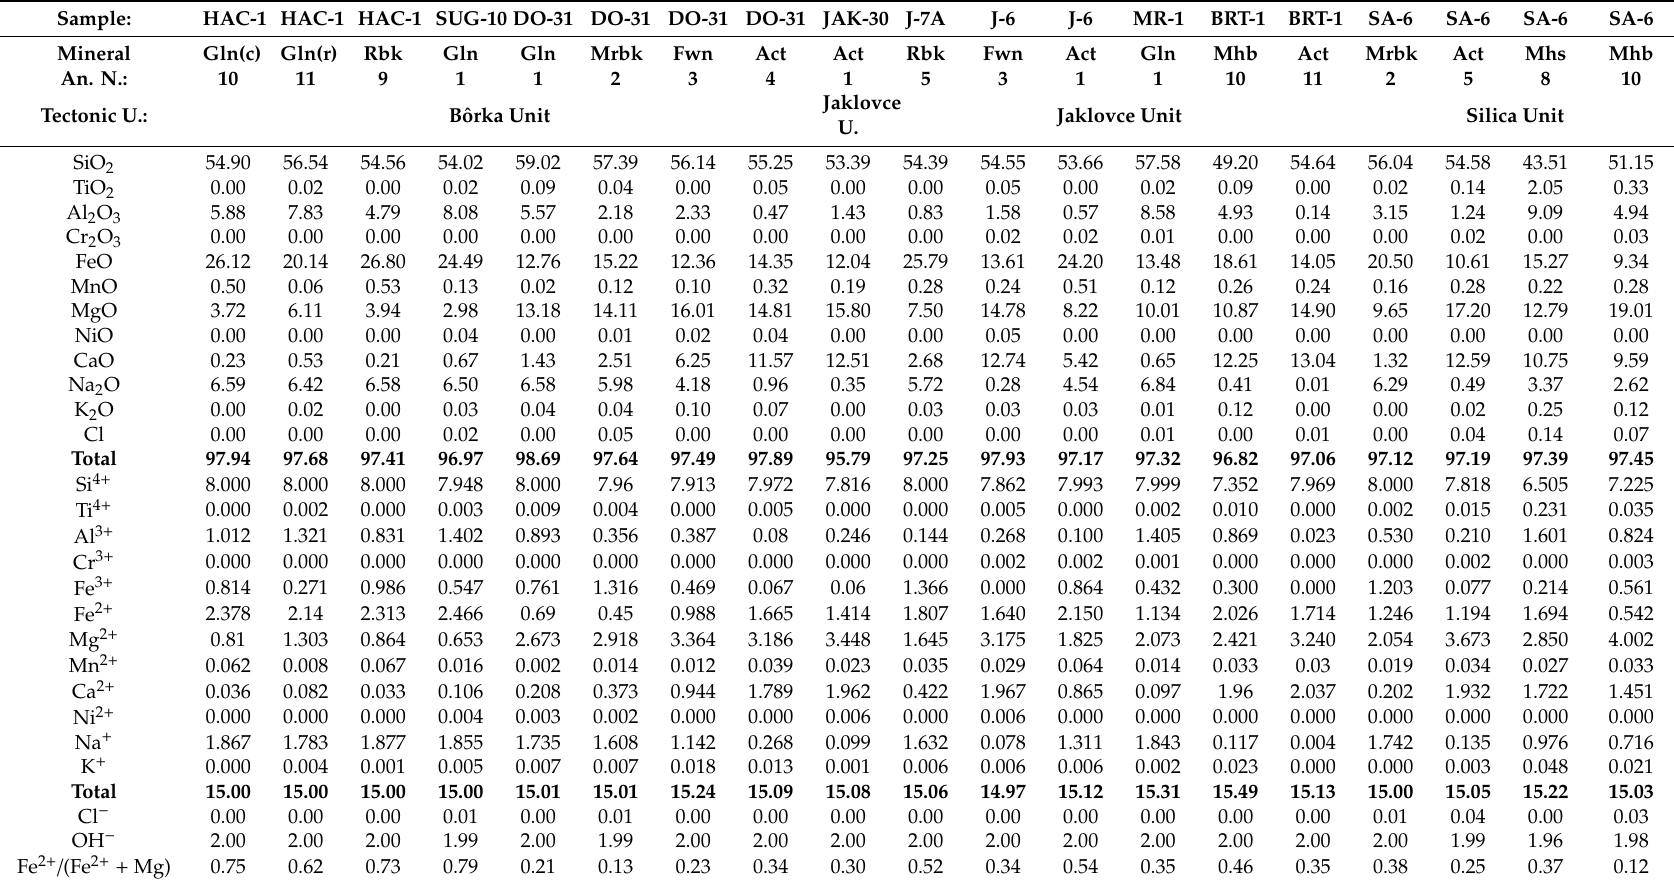
Table 3. Representative analyses of amphibole from the B ô rka, Jaklovce and Silica